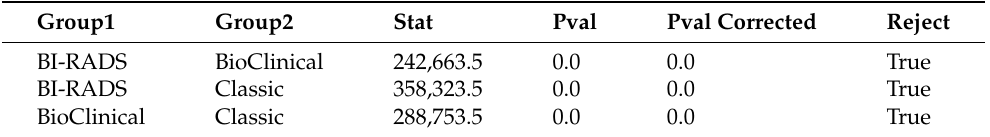
Table A5. Bonferonni-corrected Mann–Whitney U test results for section segmentation with auxiliary data in an ablation study with 10% of training data.